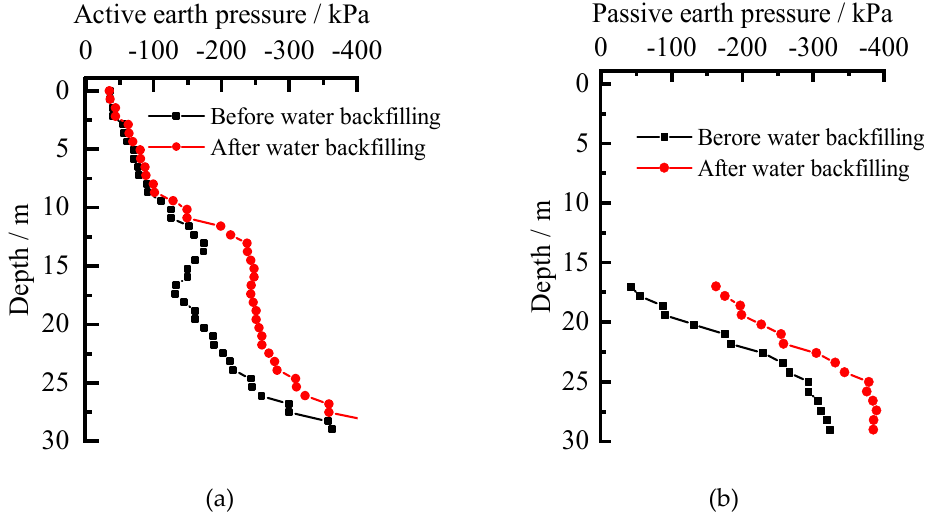
Figure 10. Soil pressure before and after water backfilling in the foundation pit. ( a ) Outside the pit; ( b ) inside the pit.